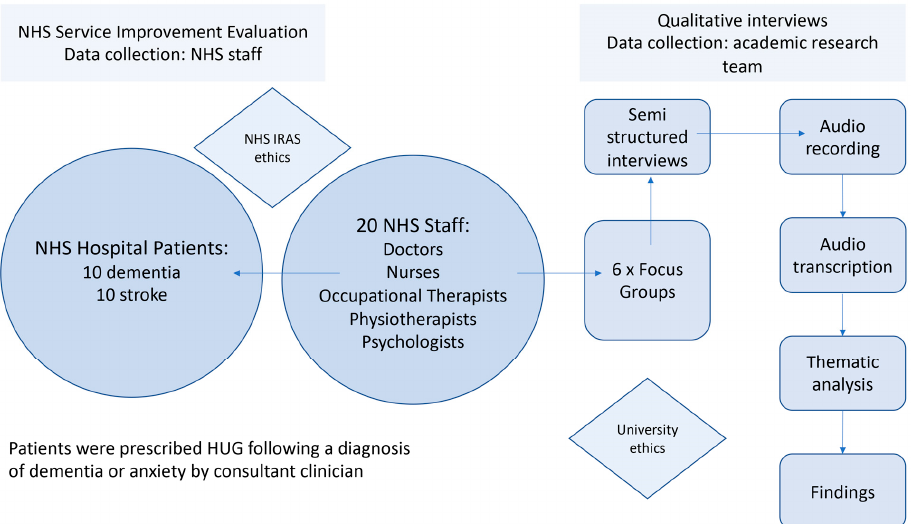
Figure 4. Research methods used in qualitative study in a hospital context. HUGs were prescribed to 20 NHS patients by consultant clinician and observations were made by MDT caring for them.